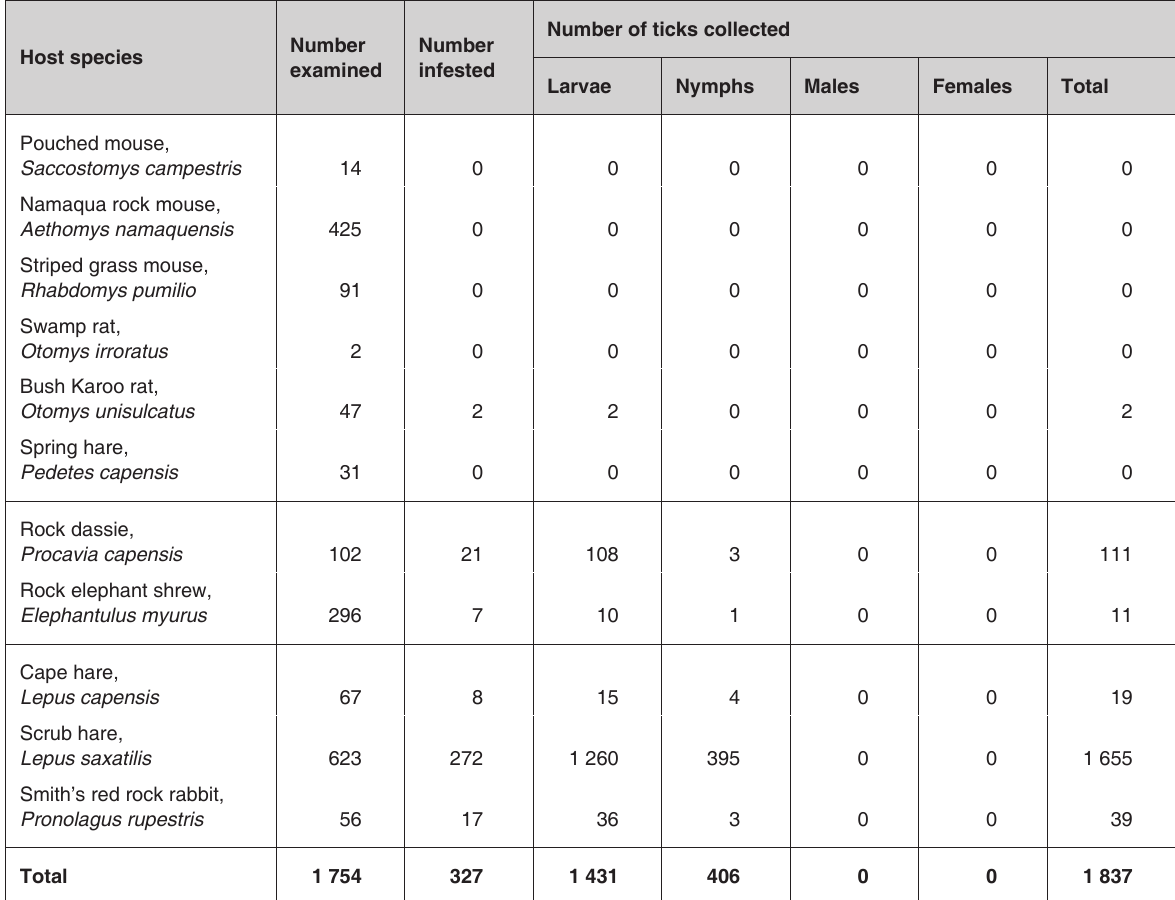
TABLE 3 Amblyomma marmoreum collected from small mammals